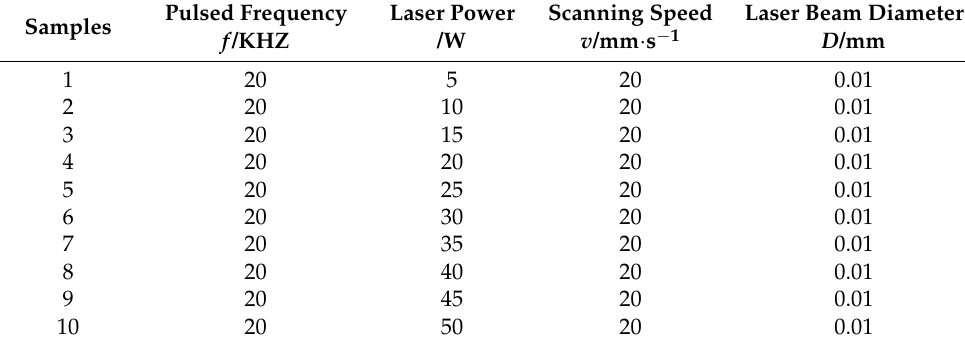
Table 3. Pulse laser etching